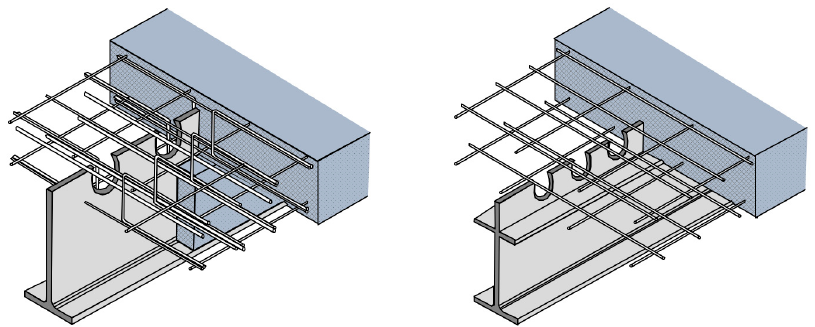
Figure 2. Possible solutions with composite dowel rib connectors.